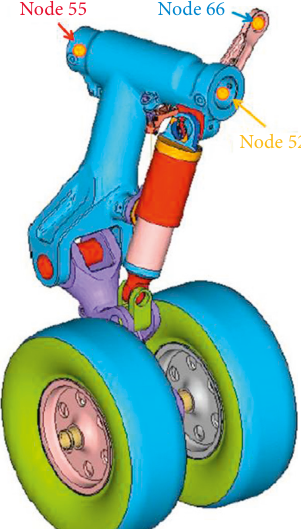
Figure 33: 3D full-FE constraints locations.